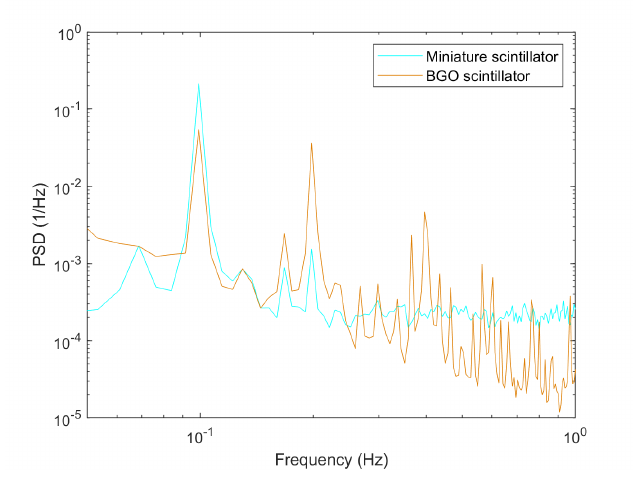
Fig. 9. Auto power spectral densities obtained with the miniature neutron scintillator (cyan) and the large BGO gamma scintillator (orange) for the oscillation of the instrumented fuel